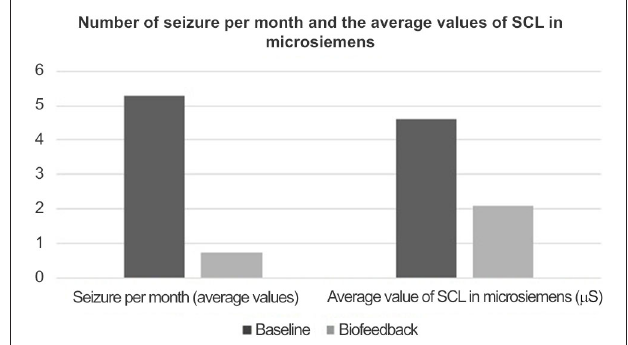
FIGURE 1 | Results of research.